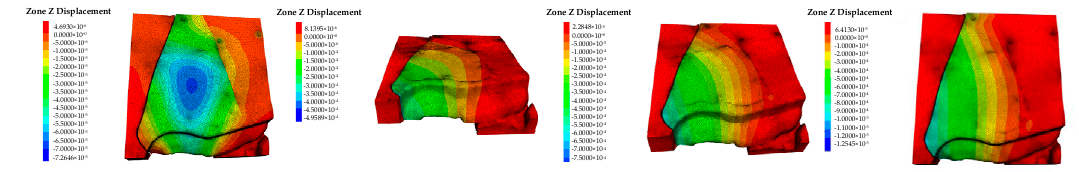
Figure 13. Vertical displacement clouds of the top slab when the number of broken slates varies. With the increase in the number of broken slate blocks, the settlement of Y6, Y8, and Y9 on the top plate of Yuanjue Cave gradually increased, the settlement of Y10 decreased, and the width of L6 cracks kept increasing. The settlement of the four monitored ones had the characteristics of Y6 > Y8 > Y9 > Y10 (Figure 14a), which is mainly since the monitoring points of Y6, Y9, and Y8 were closer to the broken slate area; when the broken slate exceeded 18 pieces (TS46), the settlement of Y6, Y8, and Y9 started to increase sharply and entered the stage of rapid change.